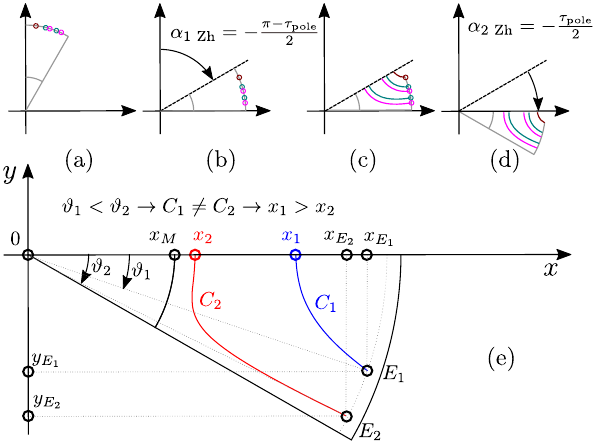
Figure 6. Zhukovsky barrier construction. Subfigures ( a )–( e ) are explained in the Sections